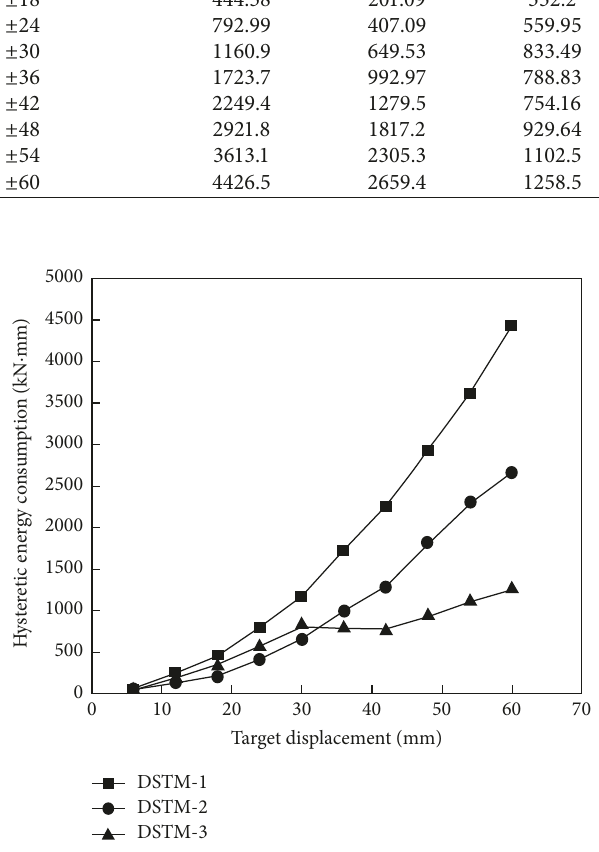
Figure 8: Hysteretic energy of